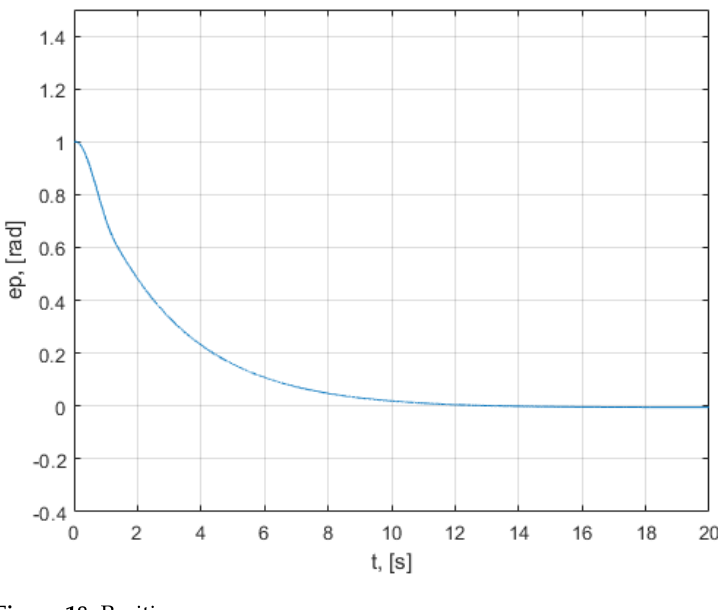
Figure 18. Position error.